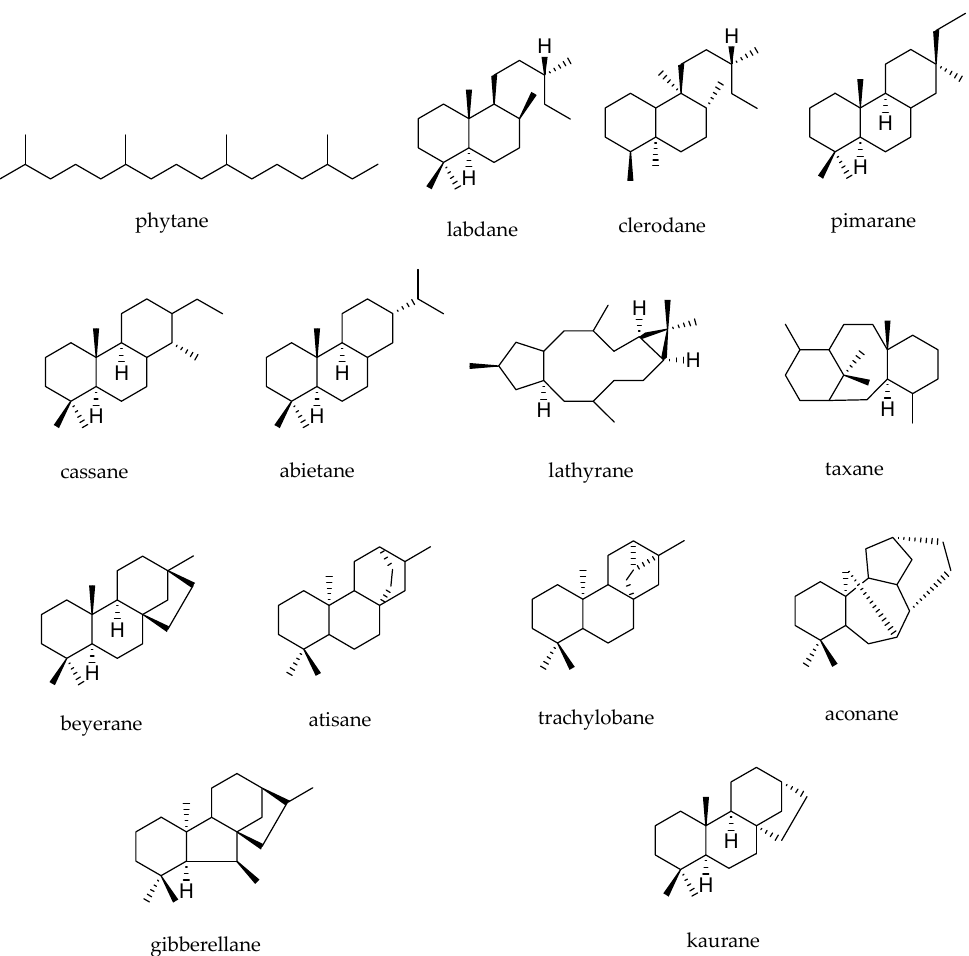
Figure 2. Common diterpene skeletal types.